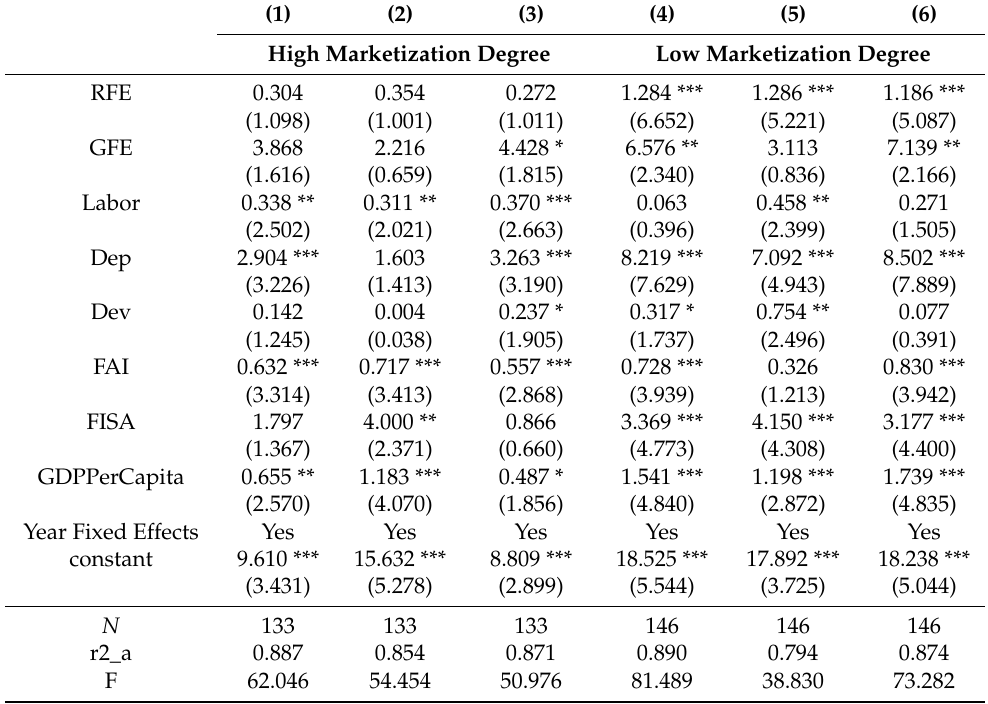
Table 4. Financial Efficiency, Marketization Degree, and Agricultural Technology Innovation.